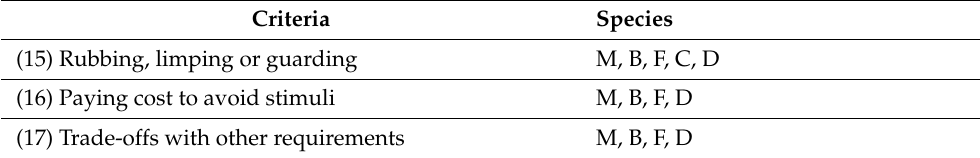
Table 1. Cont. Criteria